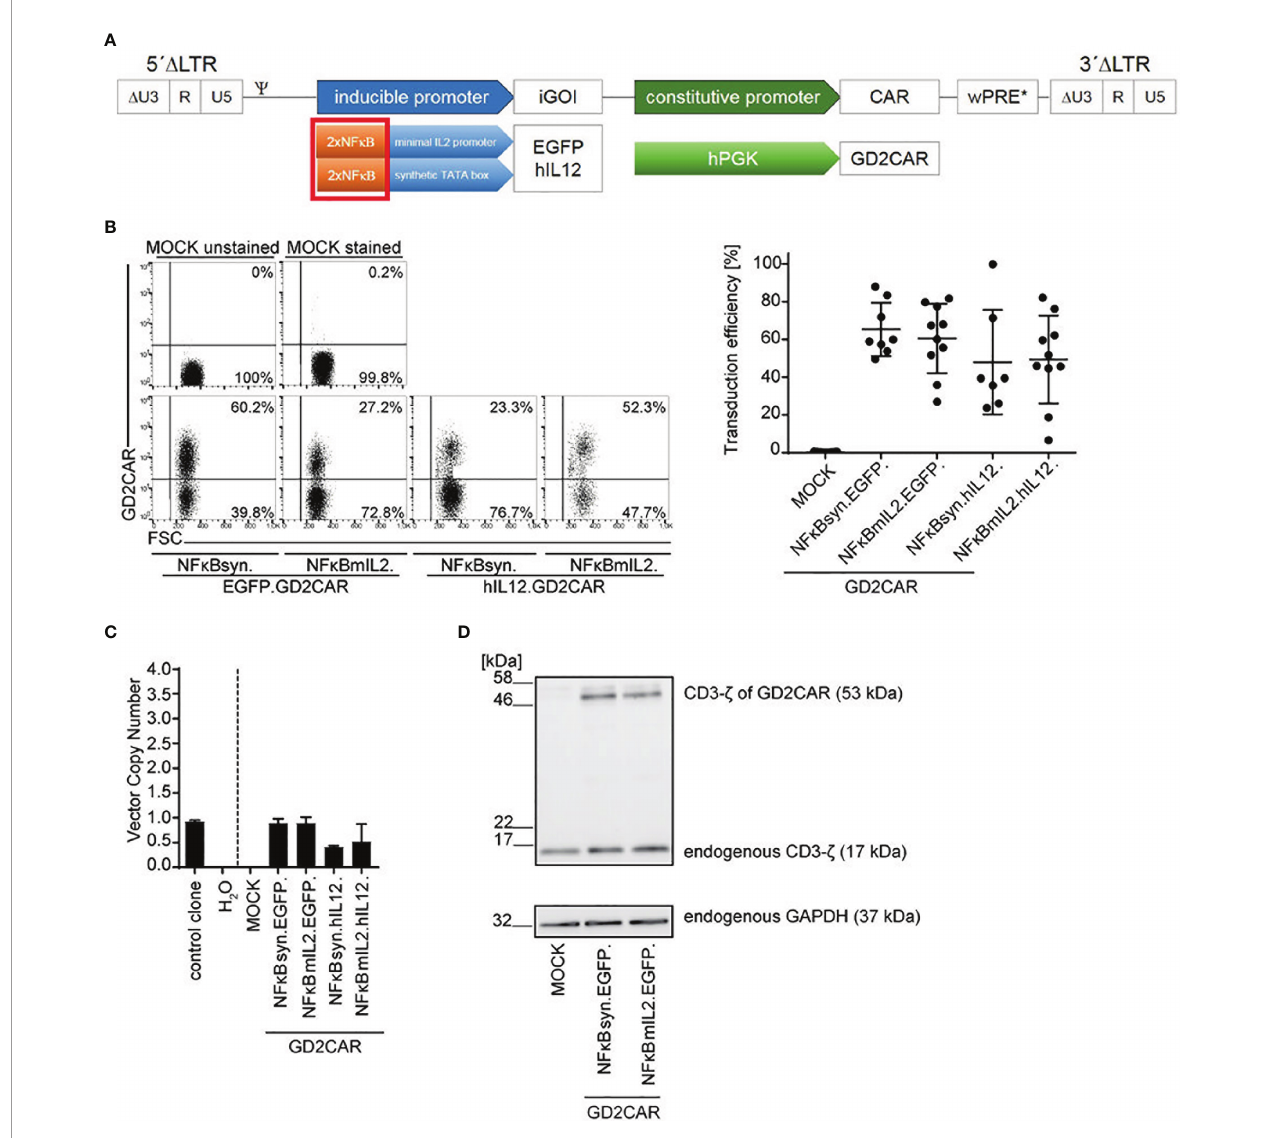
FIGURE 2 | Optimization of alpharetroviral “ all-in-one ” SIN vectors with inducible NF k B-promoter elements for NK cell application. (A) Scheme of modi fi ed alpharetroviral SIN “ all-in-one ” provirus constructs encoding a constitutively expressed GD2CAR and an iGOI, namely, EGFP or hIL-12. The iGOI expression cassette included two consensus NF k B (2xNF k B) elements in combination with either a minimal IL2 promoter (NF k BmIL2) or a synthetic TATA box (NF k Bsyn). (B) Representative fl ow cytometric analysis of unsorted modi fi ed NK-92 cells post transduction (RD114/TR-pseudotyped; MOI 10). Scatter plots summarize transduction ef fi ciencies of unsorted modi fi ed (MOI 10) NK-92 cells (n = 7 – 10). (C) VCN of unsorted modi fi ed (MOI 10) NK-92 cells. As controls, the VCNs of a water sample and an induced pluripotent stem cell (iPSC) clone HD2 (47) with a known VCN of 1 were calculated. Technical triplicates are shown. (D) CAR expression in unsorted transduced (MOI 10) NK-92 cells was exemplarily shown for NF k BmIL2.EGFP and NF k Bsyn.EGFP constructs on the protein level via Western blot analysis. The CD3- z domain of the GD2CAR (expected size approximately 53 kDa) and the endogenous CD3- z (17 kDa) as an internal control were detected. The housekeeping protein glyceraldehyde-3-phosphate-dehydrogenase (GAPDH, 37 kDa) served as a second loading control. Mean values ± SD are shown in Figure 2 . Untransduced NK-92 cells were termed